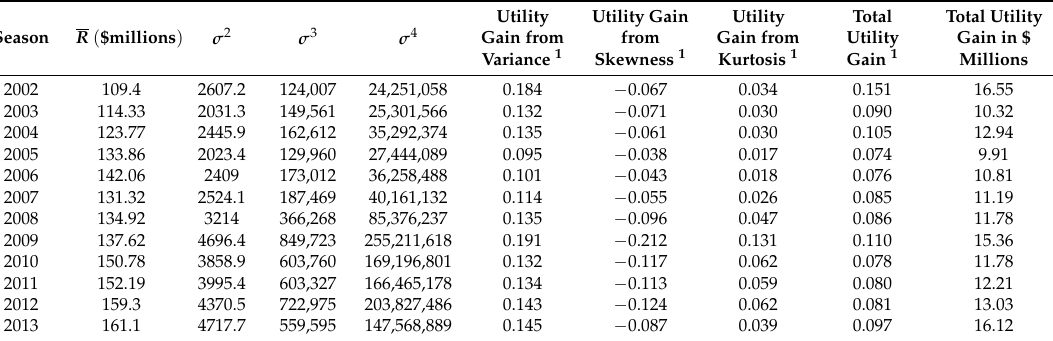
Table 2. Average utility gains per team in MLB, 2002–2013 seasons. ( α = 0.66 (2002–2006), α = 0.69 (2007–2011), α = 0.66 (2012–2013), θ =